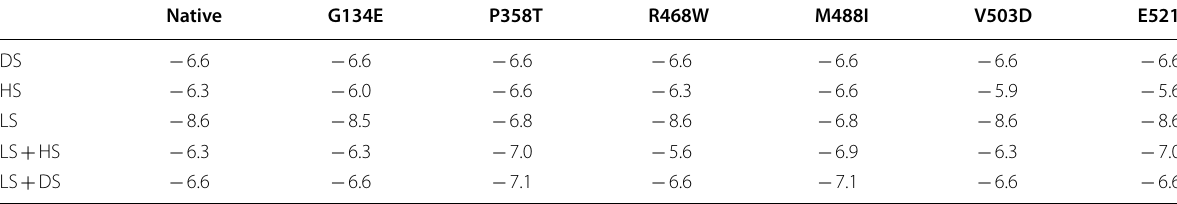
Table 6 Tabulation of Binding energies in Kcal/mol found using Autodock